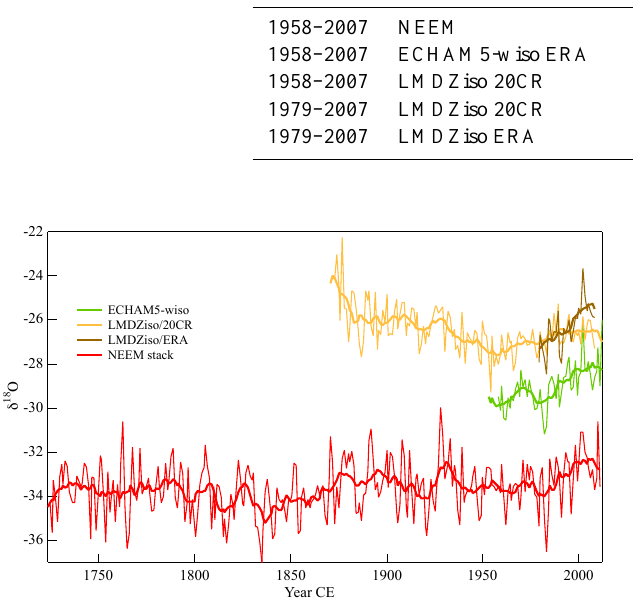
Figure 8. Comparison of NEEM δ 18 O with δ 18 O simulations (in‰).